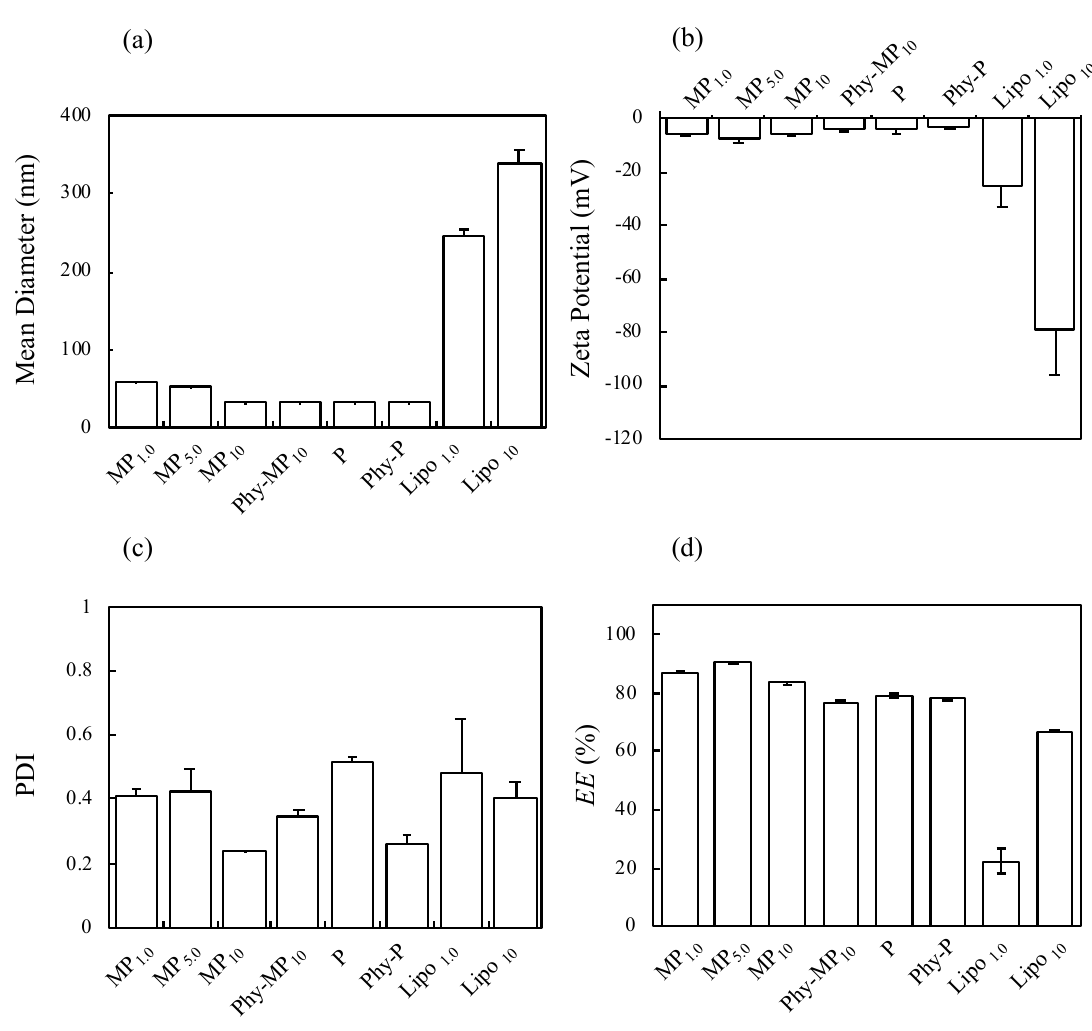
Figure 3. Measurement of particle size ( a ), zeta-potential ( b ), polydispersity index ( c ), and ( d ) entrapment efficacy of LA for prepared formulations. Each value shows the mean ± S.D. ( n = 3).